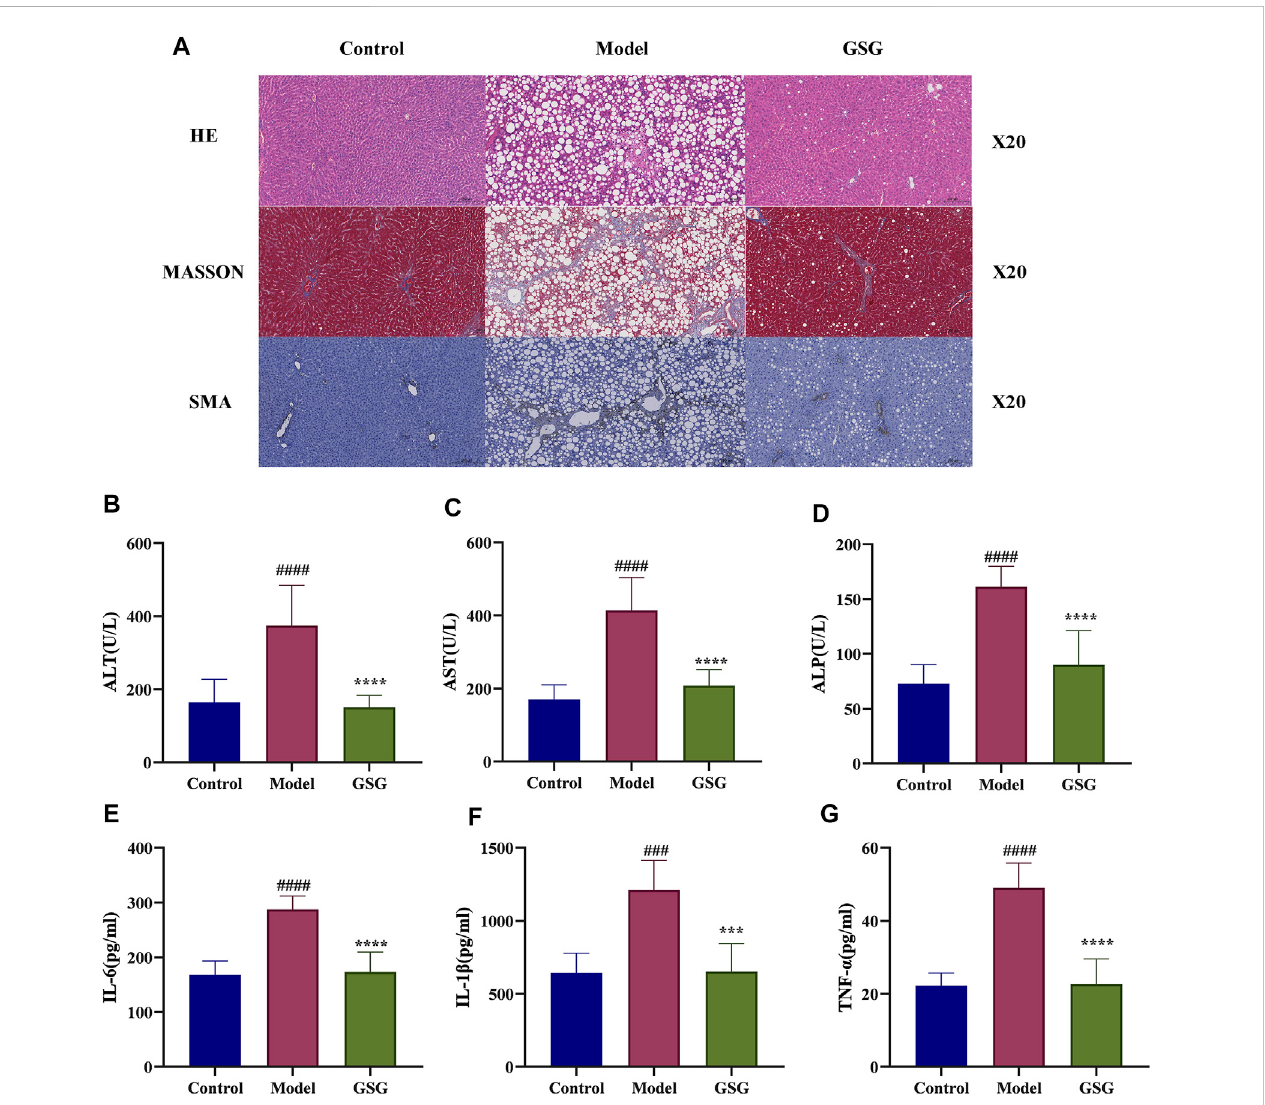
FIGURE 8 EffectsofGSGonliverdamageandin fl ammation. (A) PathologicalstainingandSMAimmunohistochemicalstainingineachgroup. (B – D) Serumlevelsof ALT, AST, and ALP in each group. (E – G) Levels of IL-6, IL-1 β , and TNF- α in liver tissue in each group. Data are the mean ± S.E.M.; #### p < 0.0001 vs. control; **** p < 0.0001 vs. model; n =